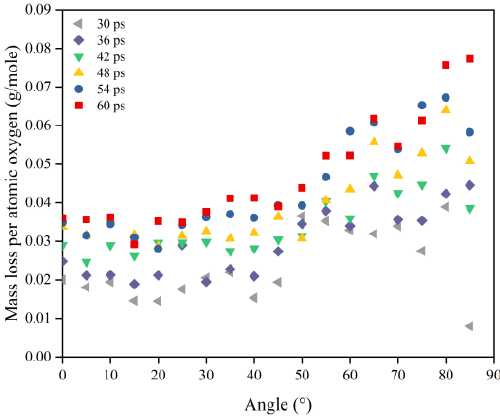
Figure 12. Mass loss of the Kapton caused by atomic oxygen at different incident angles at different time nodes.